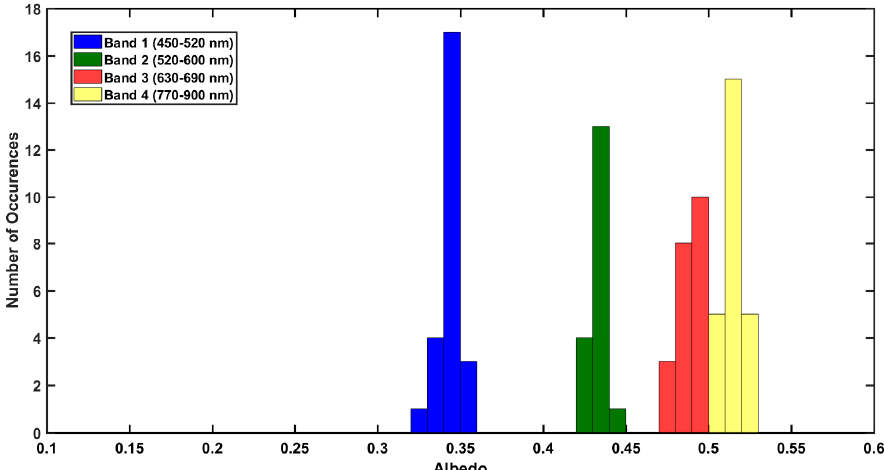
Figure 14. Histogram of neighboring LANDSAT7 ETM+ pixels over non-road location on 5 October 2017.